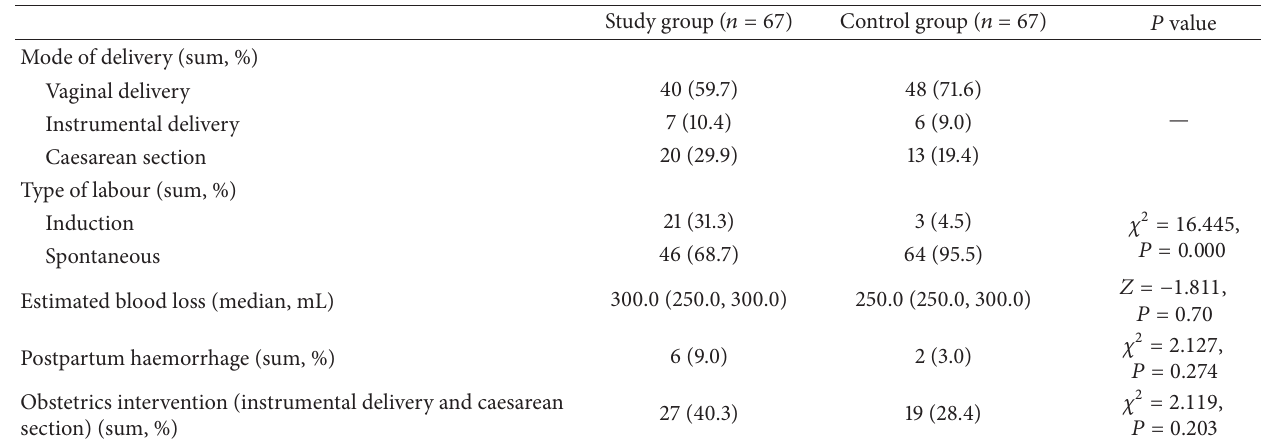
Table 4: Maternal labour outcome.